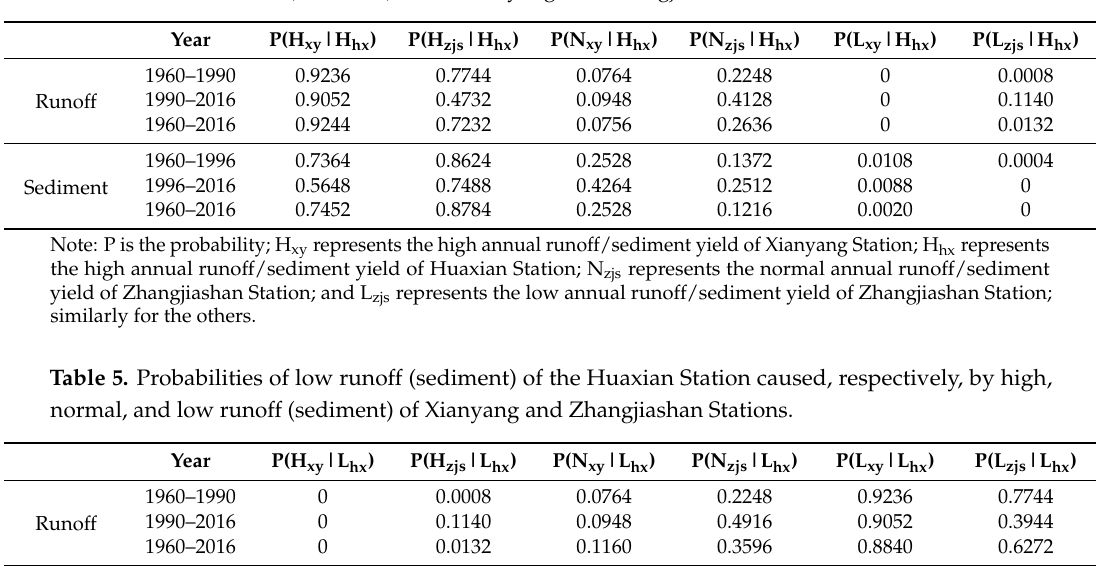
Table 4. Probabilities of high runoff (sediment) of the Huaxian Station caused, respectively, by high, normal, and low runoff (sediment) of the Xianyang and Zhangjiashan Stations.